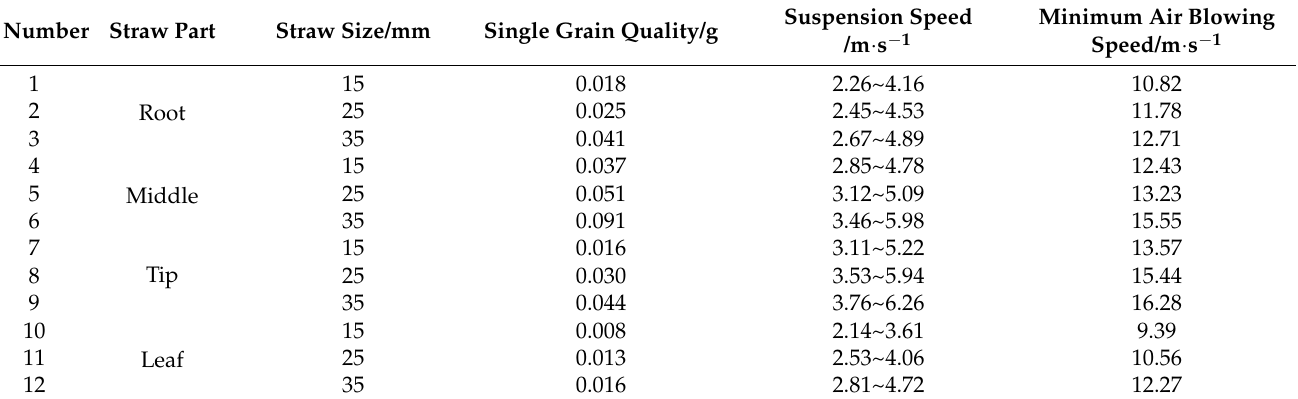
Table 2. Suspension speed test results of straw